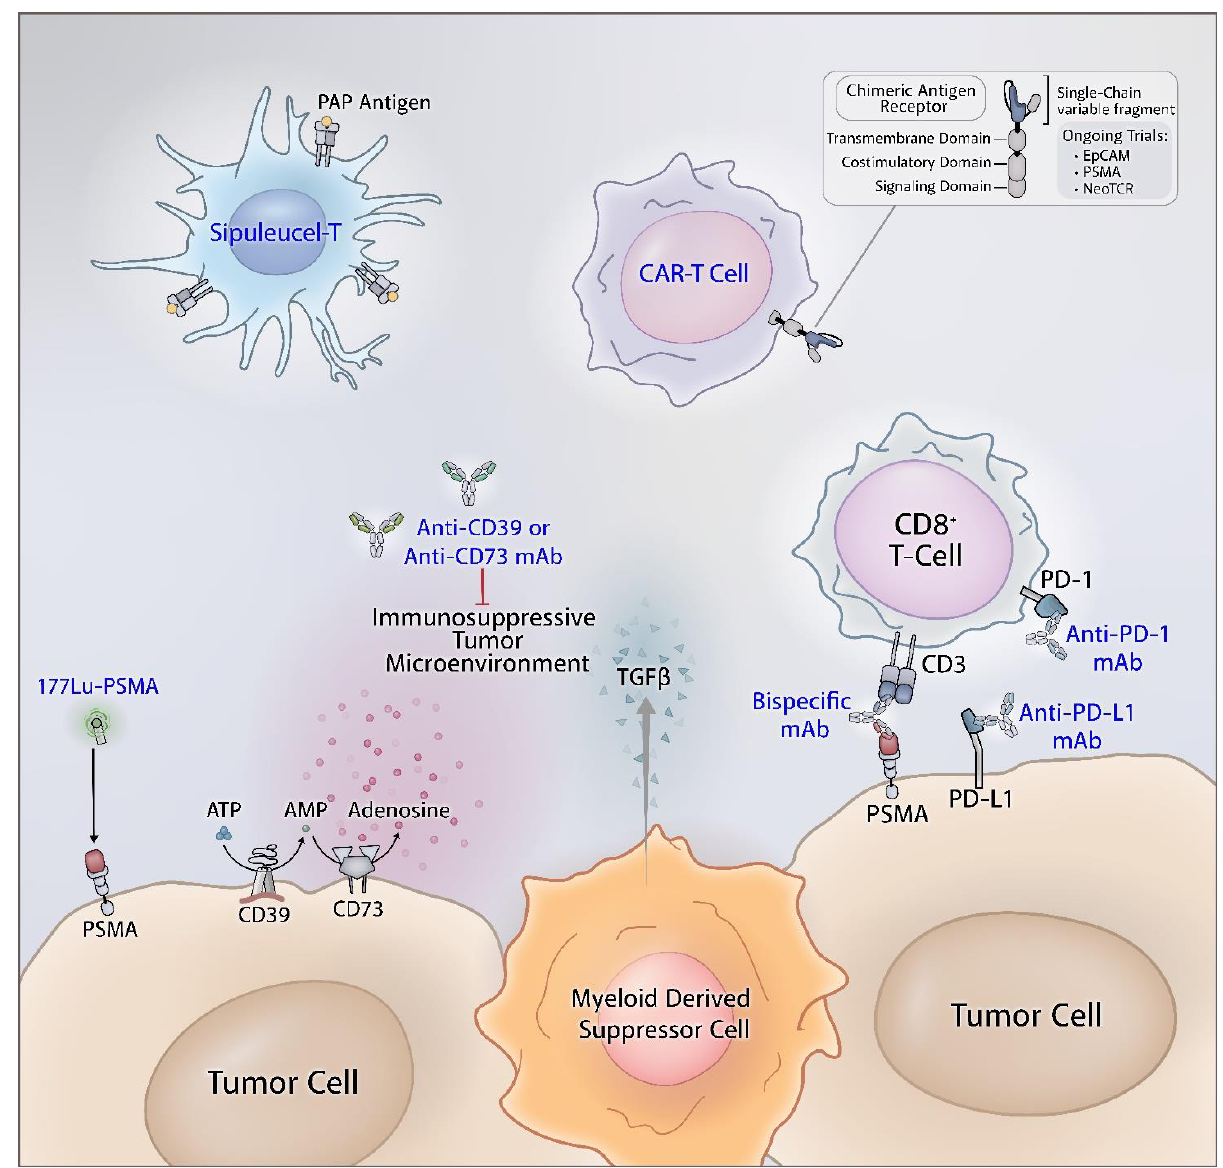
tumor-specific neoantigens. ( C ) Treatment with poly-ADP (ribose) polymerase inhibitors (PARPis) can cause DNA to leak into the cytoplasm and trigger the cGAS-STING pathway which can induce an immunostimulatory response. Figure cre- ated via Adobe Inc. (2021). Adobe Illustrator version 25.2.3. Retrieved from https://adobe.com/products/illustrator (ac- cessed on 11 April 2021).